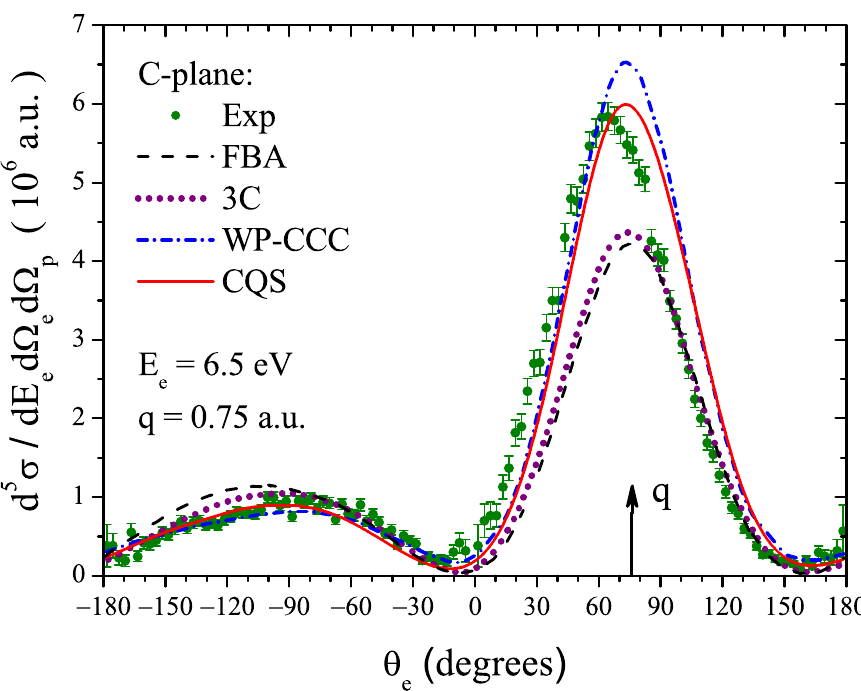
Figure 3. FDCS for single ionization of helium by 1-MeV protons in the collision plane. The electron emission energy is E e = 6.5 eV, and the total momentum transfer q = 0.75 a.u. Solid curve shows the results obtained with our method of convoluted quasi-Sturmians (CQS). Experimental data are shown by filled circles with error bars, the FBA and 3C calculations (using a strongly correlated ground-state wave function of helium [25]) by dashed and dotted lines respectively, and the dash-dotted line represents the WP-CCC